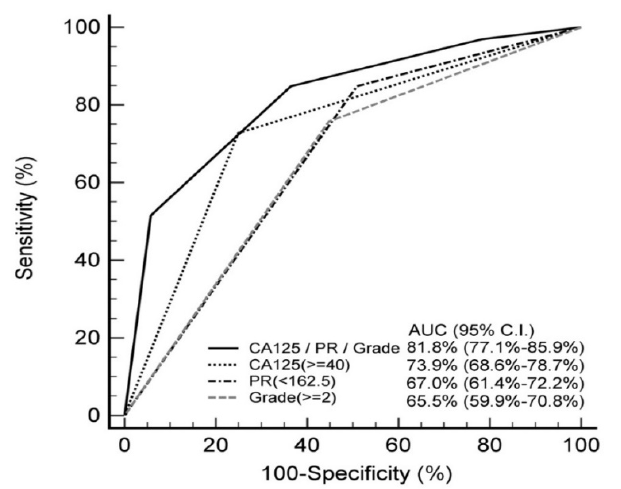
Figure 3. Comparison of area under ROC curve in different variables .